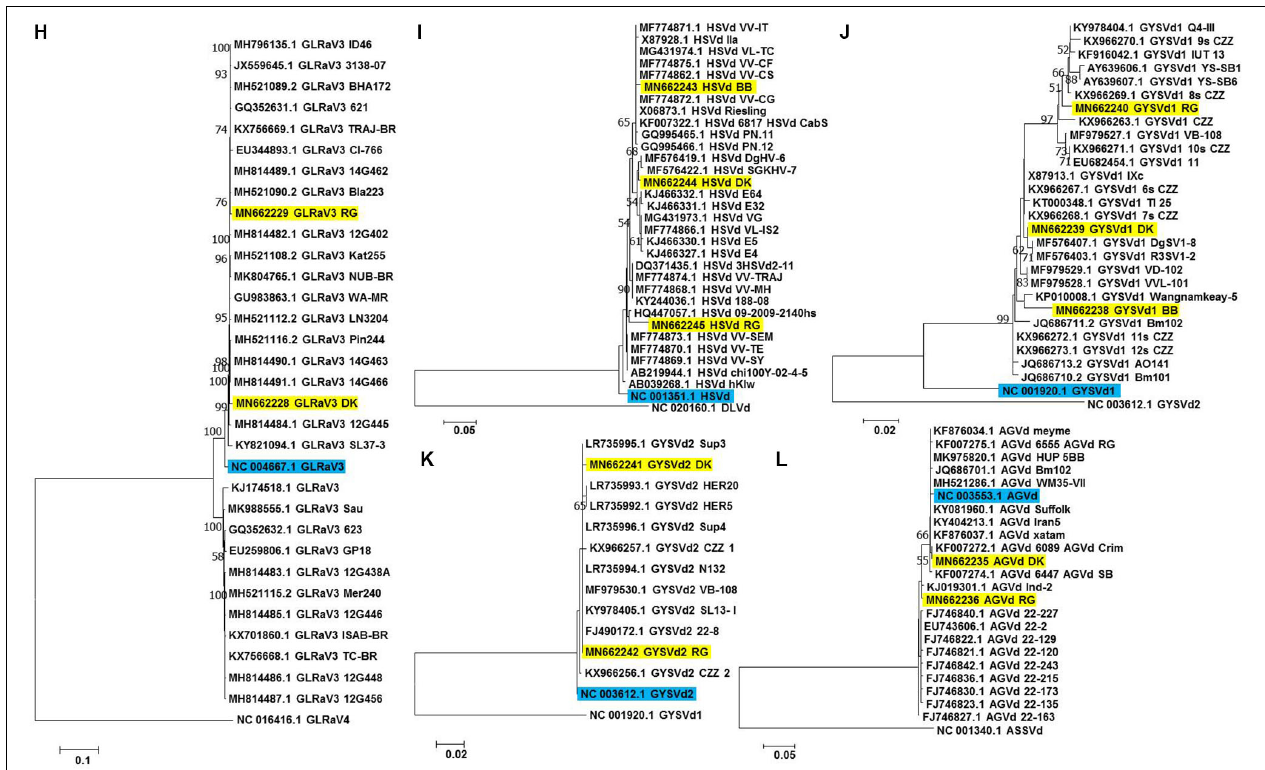
FIGURE 4 | Phylogenetic analyses for genome reconstructed viruses and viroids. Phylogenetic relationships of GVB (A) , GLRaV4 (B) , GRVFV (C) , GGVA (D) , GVL (E) GLVd (F) , GRSLaV (G) , GLRaV3 (H) , HSVd (I) , GYSVd1 (J) , GYSVd2 (K), and AGVd (L) isolates obtained in this study with global isolates. Phylogenetic tree was constructed using Neighborhood joining (NJ) method and Kimura 2-parameter model (K2P) with 1000 bootstrap replicates. Yellow colored boxes indicate the isolates obtained in this study. Blue colored boxes indicate the corresponding NCBI designated reference genome. Only bootstrap values more than 50 are shown. An outgroup was used in the analysis of each